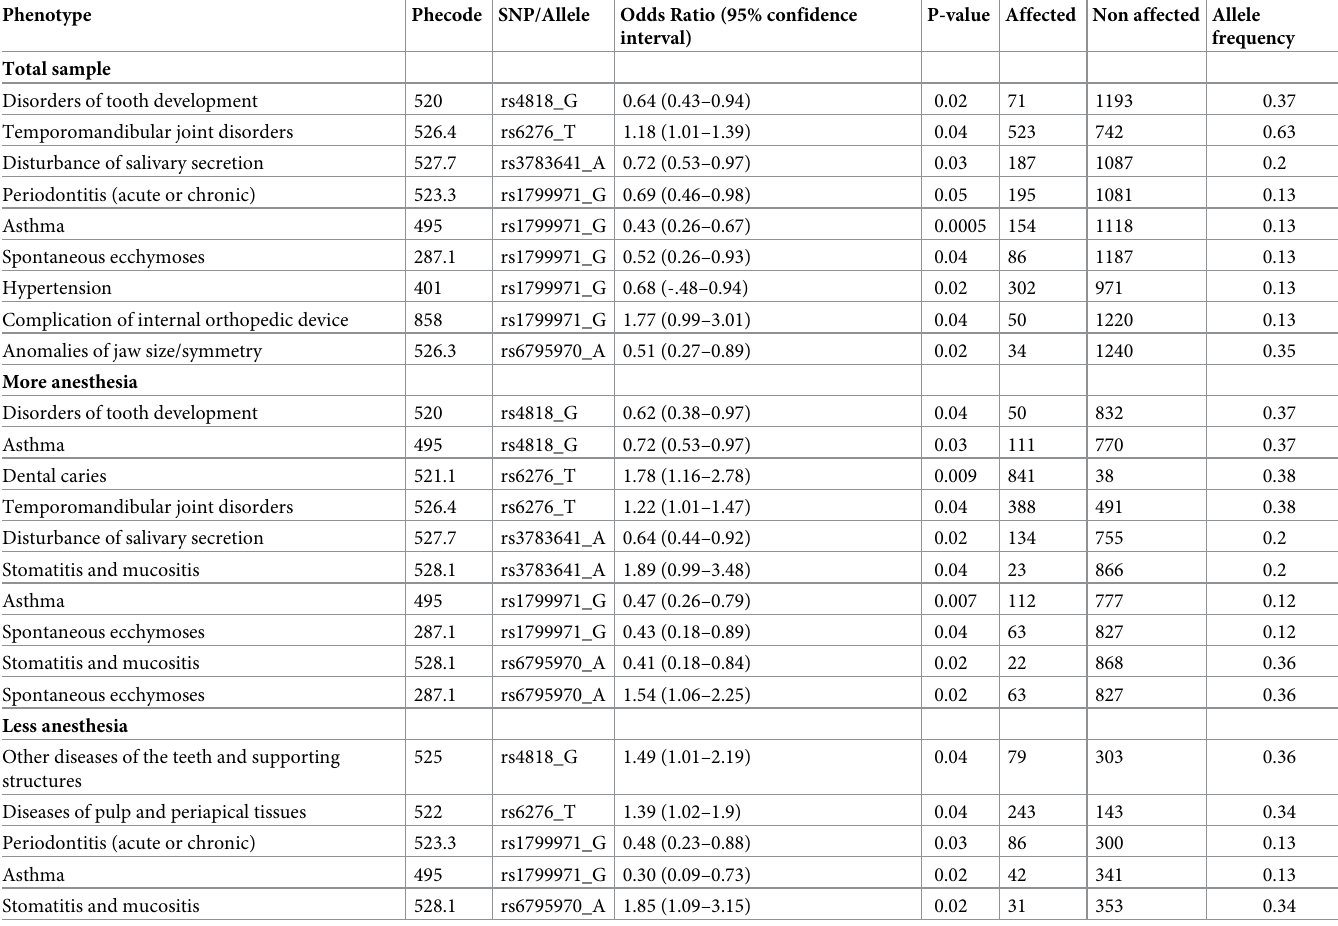
Table 3. Summary of the results of PheWAS analysis of p-values between 0.00025 and 0.05 for the total sample, for the group that received more anesthesia and for the group that received the least amount of